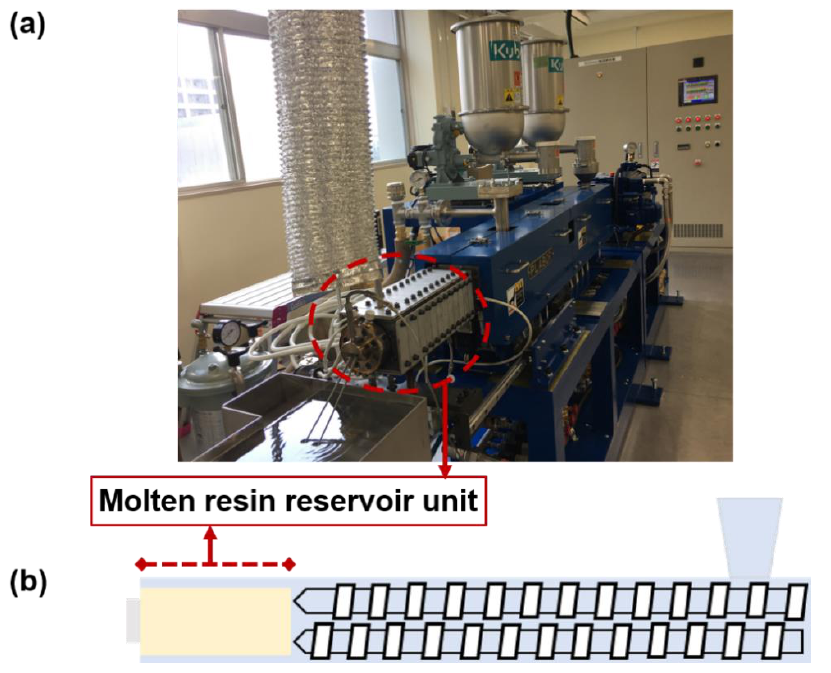
Figure 2. ( a ) Photo image of the twin-screw extruder with the additional molten resin reservoir unit; ( b ) Schematic image of the molten resin reservoir unit.